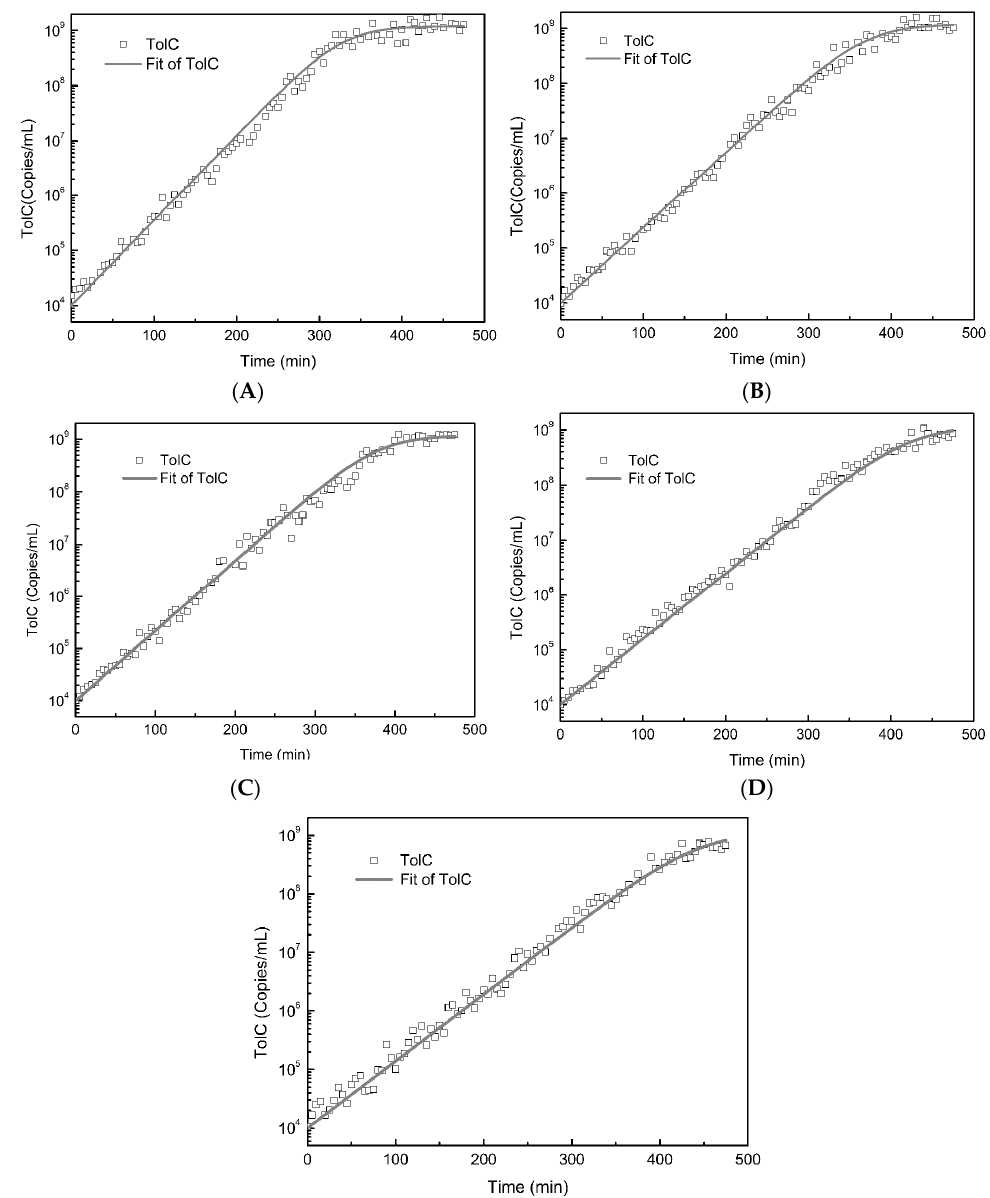
Figure 2. Bacterial growth curves according to qPCR of TolC and mathematical model fitting. ( A ) No exposure to iron oxide nanoparticles; Ψ = 0.03567 min − 1 , R 2 = 0.89829; ( B ) Exposure to 0.05 mM iron oxide nanoparticles; Ψ = 0.03166 min − 1 , R 2 = 0.92372; ( C ) Exposure to 0.5 mM iron oxide nanoparticles; Ψ = 0.03092 min − 1 , R 2 = 0.96471;( D ) Exposure to 5 mM iron oxide nanoparticles; Ψ = 0.02762 min − 1 , R 2 = 0.93038;( E ) Exposure to 10 mM iron oxide nanoparticles; Ψ = 0.0263 min − 1 , R 2 = 0.93326.